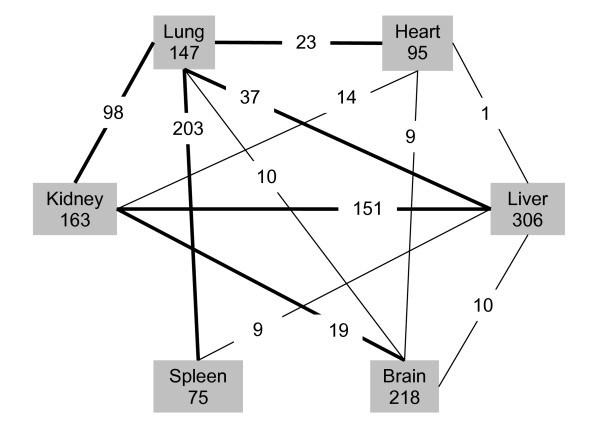
Summary of differentially expressed genes among 6 organs. The number under an organ represents the genes that are expressed significantly higher in the respective organ compared to other organs (p < 0.05). Similarly, the number between any two organs represents the genes that are expressed significantly higher in the two organs compared to other organs (p < 0.05). Thicker lines highlight a larger number of the genes co-expressed in the respective two organs.